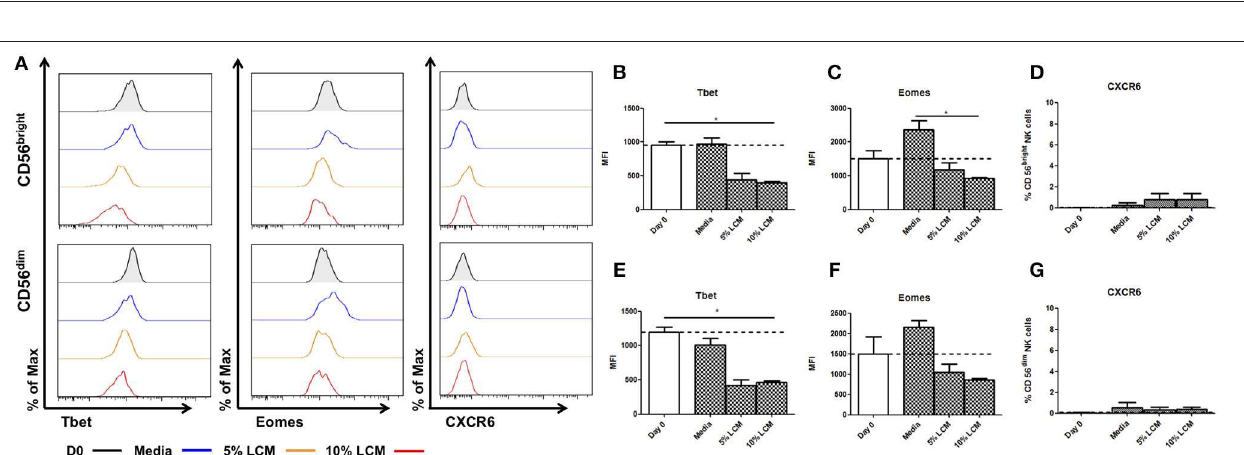
FIGURE 3 | Liver resident phenotype can be maintained by the addition of liver conditioned media. NK cells isolated from liver perfusate (LP) were cultured for 7 days, supplemented with 5 or 10% v/v liver conditioned media (LCM) and stained with monoclonal antibodies to assess transcription factor expression. (A) Representative histograms of Tbet, Eomes and CXCR6 expression from cells at day 0 (black line), day 7 untreated (blue line), day 7 5% LCM (orange line), and day 7 10% LCM (red line). (B) MFI of Tbet CD56 bright NK cells from LP at day 0 and 7 with LCM treatments. (C) MFI of Eomes in CD56 bright NK cells from LP at day 0 and 7 with LCM treatments. (D) Percentage of CXCR6 positive CD56 bright NK cells from LP at day 0 and 7 with LCM treatments. (E) MFI of Tbet in CD56 dim NK cells from LP at day 0 and 7 with LCM treatments. (F) MFI of Eomes in CD56 dim NK cells from LP at day 0 and 7 with LCM treatments. (G) Percentage of CXCR6 positive CD56 dim NK cells from LP at day 0 and 7 with LCM treatments. Data presented as mean ± SEM. Data was analyzed using Friedman test, with Dunn’s multiple comparison test ( n = 5; * p < 0.05).